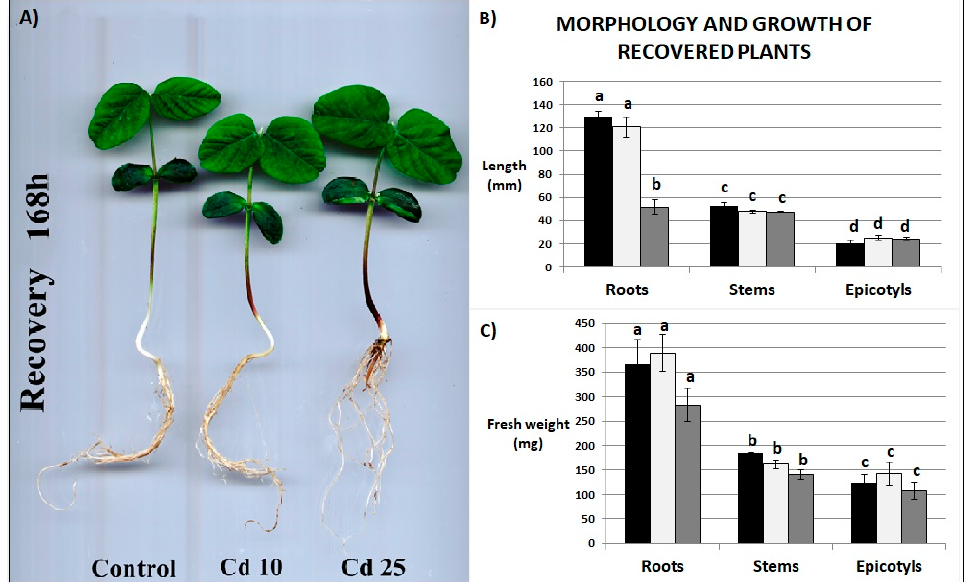
Figure 3. Morphology of recovered plants ( A ), length ( B ) and fresh weight ( C ) of roots, stems and epicotyls. Black bars—control plants, light grey bars—plants stressed previously with Cd at the concentration 10 mg / L, dark grey bars—plants stressed previously with Cd at the concentration 25 mg / L. Results are the means of three independent experiments ± SE . Results showing no statistically significant di ff erences in relation to control by p = 0.05 are marked with same